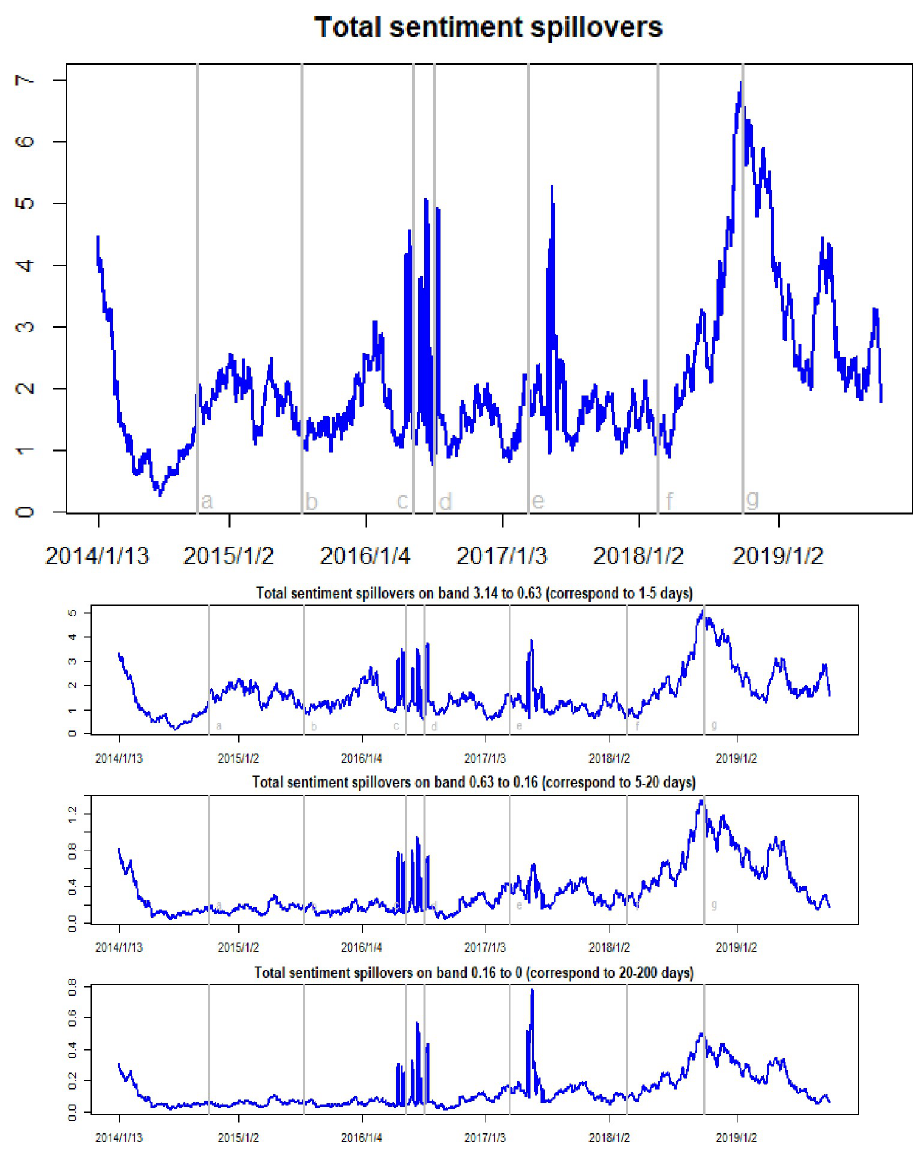
Fig 2. Time-frequency dynamics of total sentiment spillovers. a, b, c, d, e, f, g respectively represent the seven events: the WTI oil price collapsed in October 2014, the black swan event in gold market occurred in July 2015, the sharp rise of bitcoin prices in May 2016, the Brexit event in July 2016, the expectations of a Federal Reserve rate hike in March 2017, the price of Bitcoin and gold fluctuating fall at the beginning of 2018, and the WTI oil price declines in August 2018.